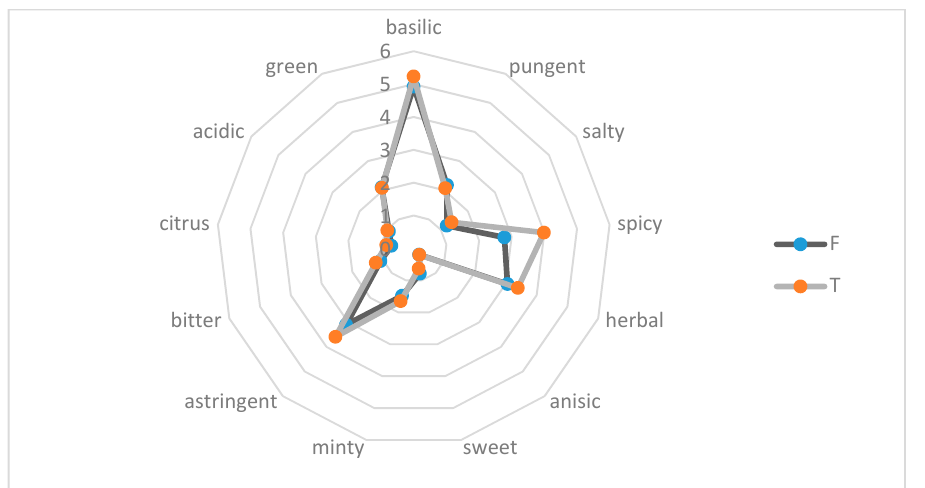
Figure 2. Diagram of sensory profile of fresh herb taste.